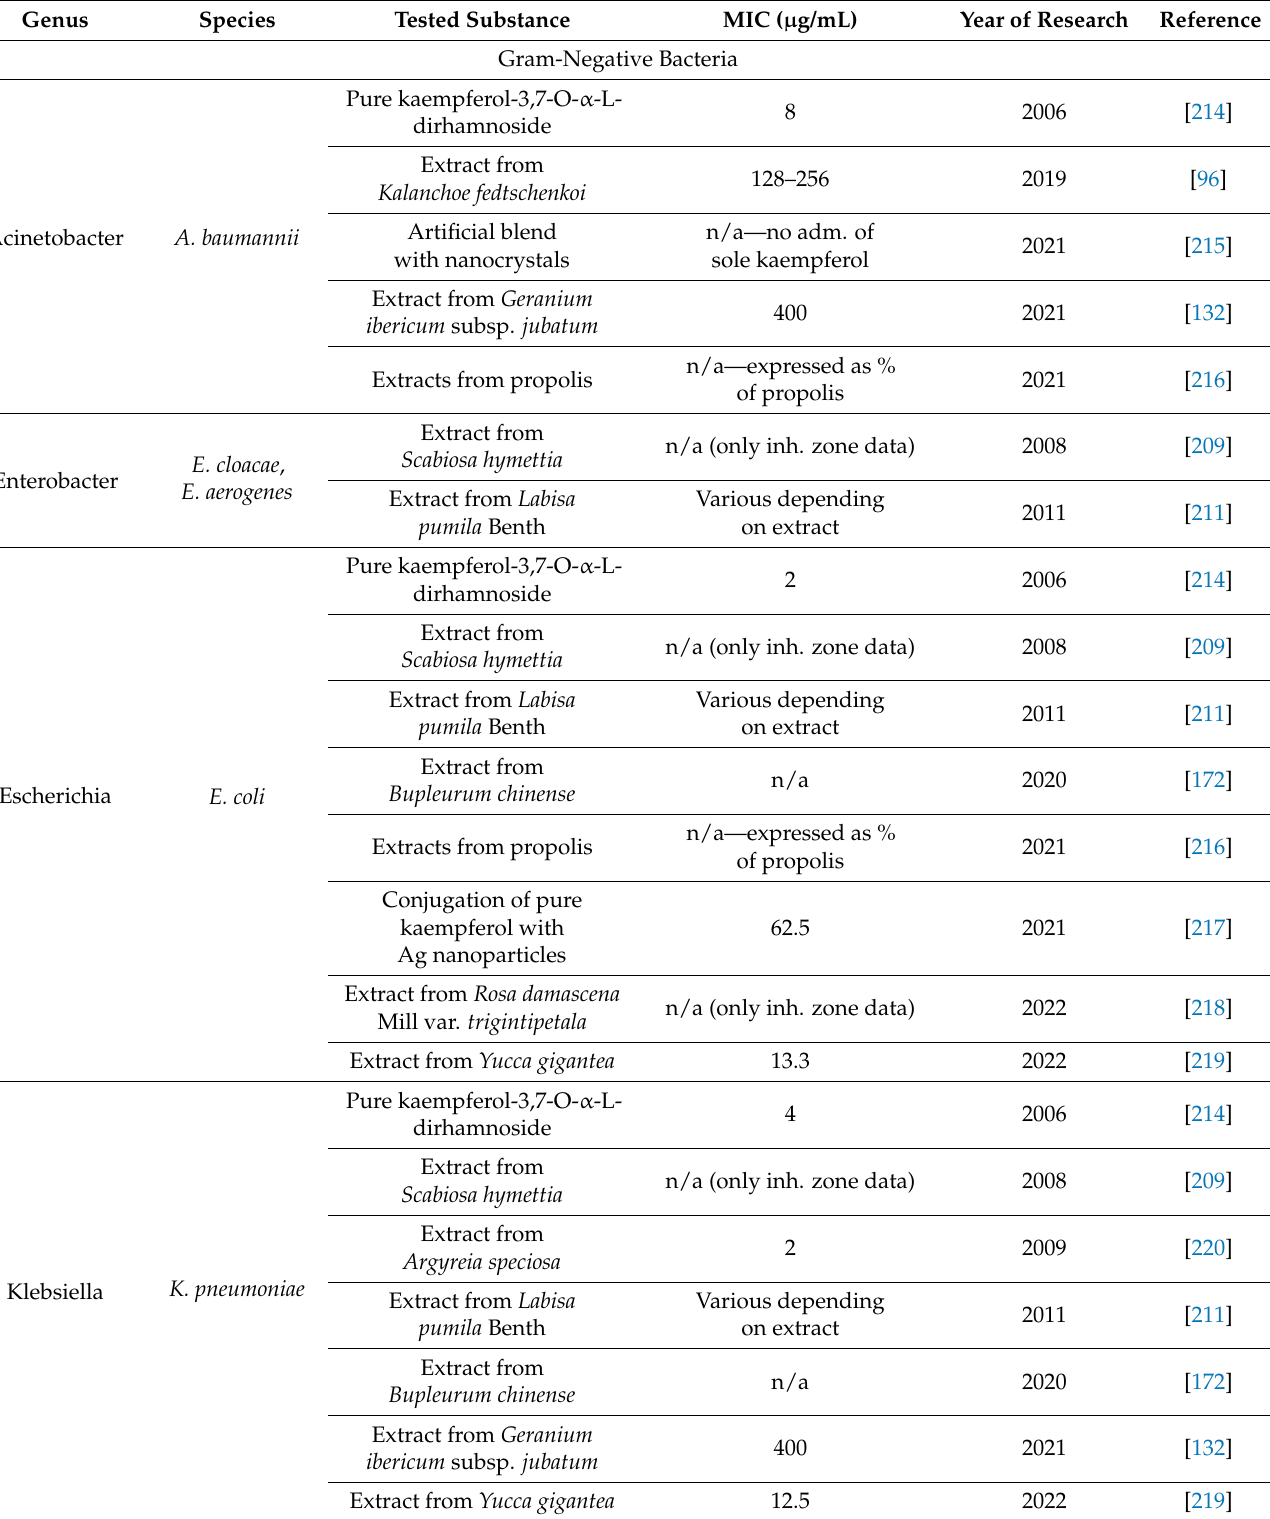
Table 3. Kaempferol compounds and their antibacterial activities based on current